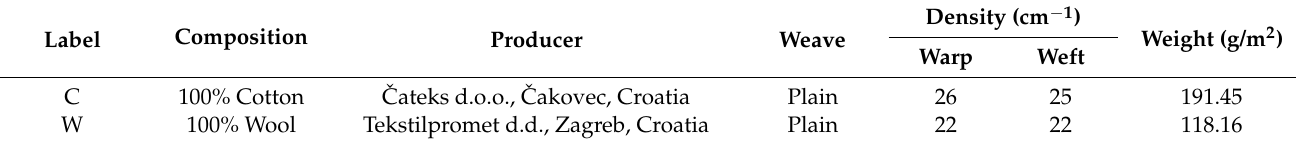
Table 1. Technical characteristic parameters of used fabrics.